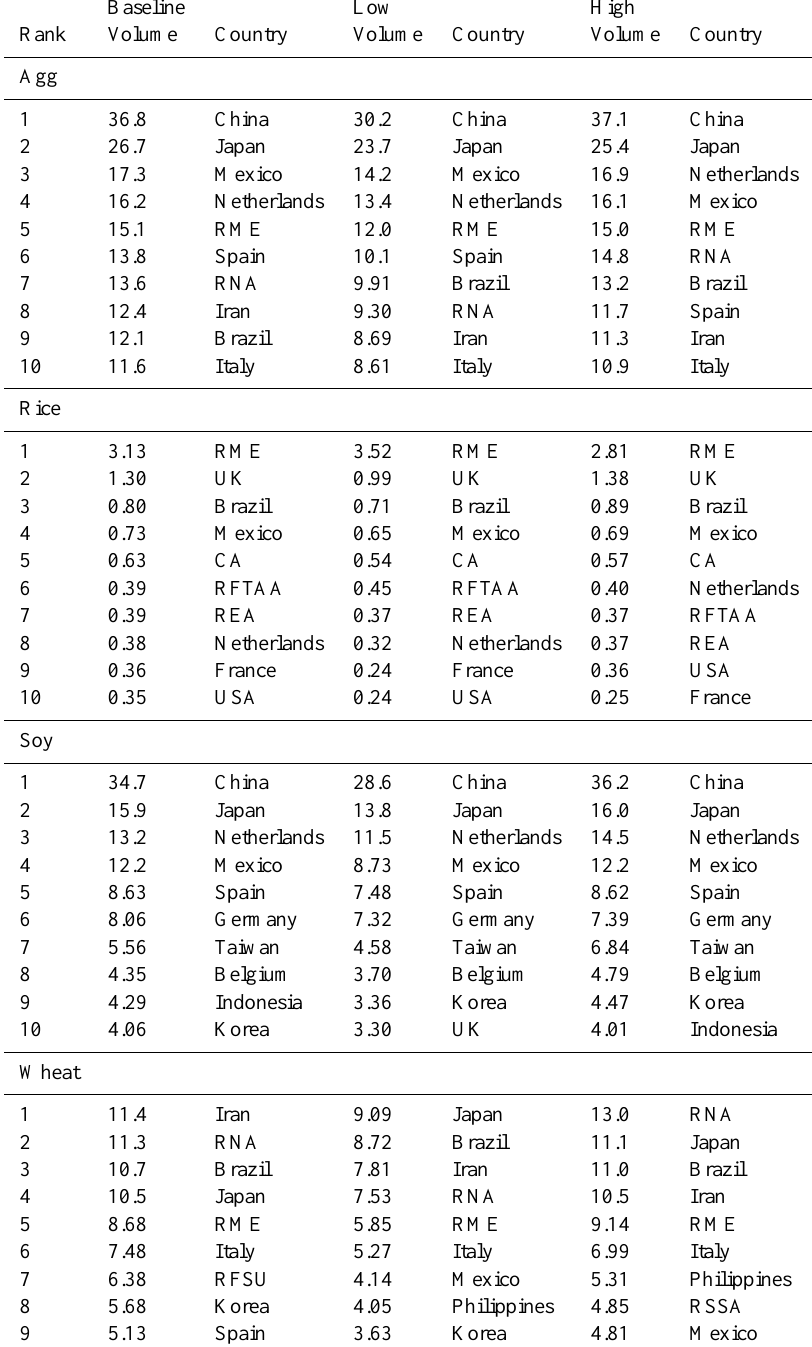
Table 2. Top importers of virtual water by crop under the baseline, low-, and high-yield scenarios. All values are in billions of cubic meters. RME indicates Rest of Middle East, CA indicates Central America, RFTAA indicates Rest of Free Trade Area of the Americas, RSSA indicates Rest of sub-Saharan Africa, REA indicates Rest of East